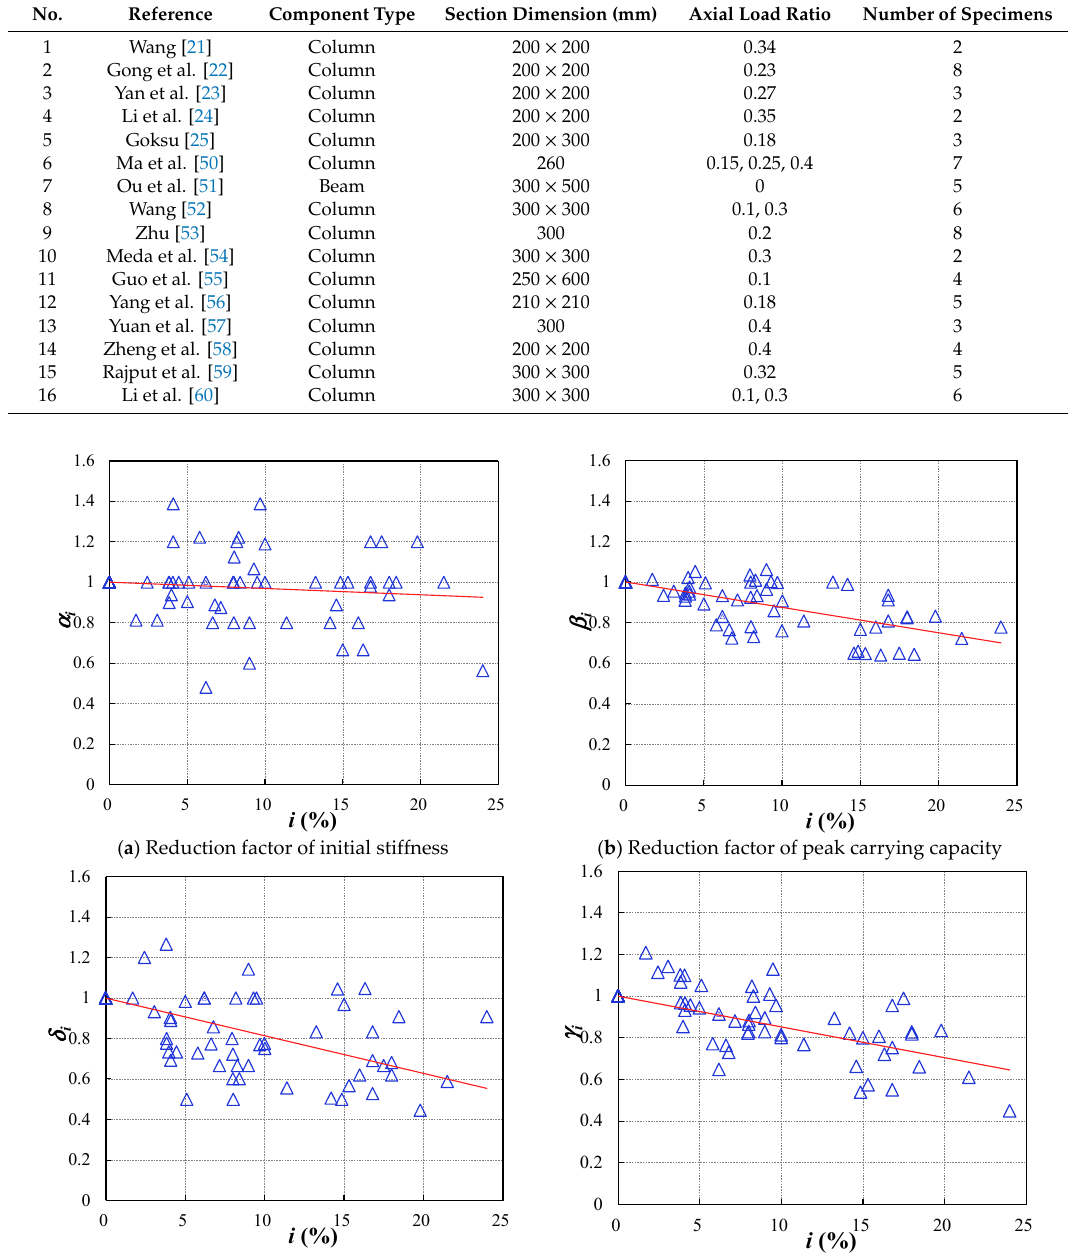
Table 1. Properties of collected specimens.